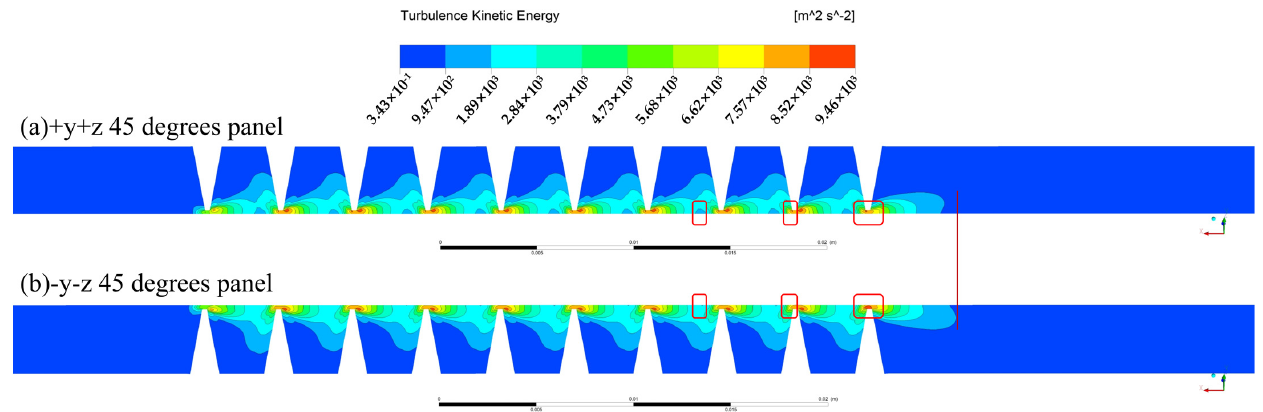
ω Ω ω Figure 16. Turbulence kinetic energy contour of HDLS ( = 5000 rpm, = 50 Hz). Ω Figure 16. Turbulence kinetic energy contour of HDLS ( = 5000 rpm, = 50 Hz). Figure 16. Turbulence kinetic energy contour of HDLS ( ω = 5000 rpm, Ω = 50 Hz). The turbulence kinetic energy curves can be drawn as in Figure 17, by extracting val- The turbulence kinetic energy curves can be drawn as in Figure 17, by extracting val- The turbulence kinetic energy curves can be drawn as in Figure 17, by extracting ues on the line of the positive y-direction with different whirl frequencies considered at ues on the line of the positive y-direction with different whirl frequencies considered at values on the line of the positive y-direction with different whirl frequencies considered 5000 rpm rotation speed. It is obviously found that the turbulence kinetic energy in cavi- 5000 rpm rotation speed. It is obviously found that the turbulence kinetic energy in cavi- ties 2 to 9 presents a whirl frequency dependence much more than that of the domain ties 2 to 9 presents a whirl frequency dependence much more than that of the domain